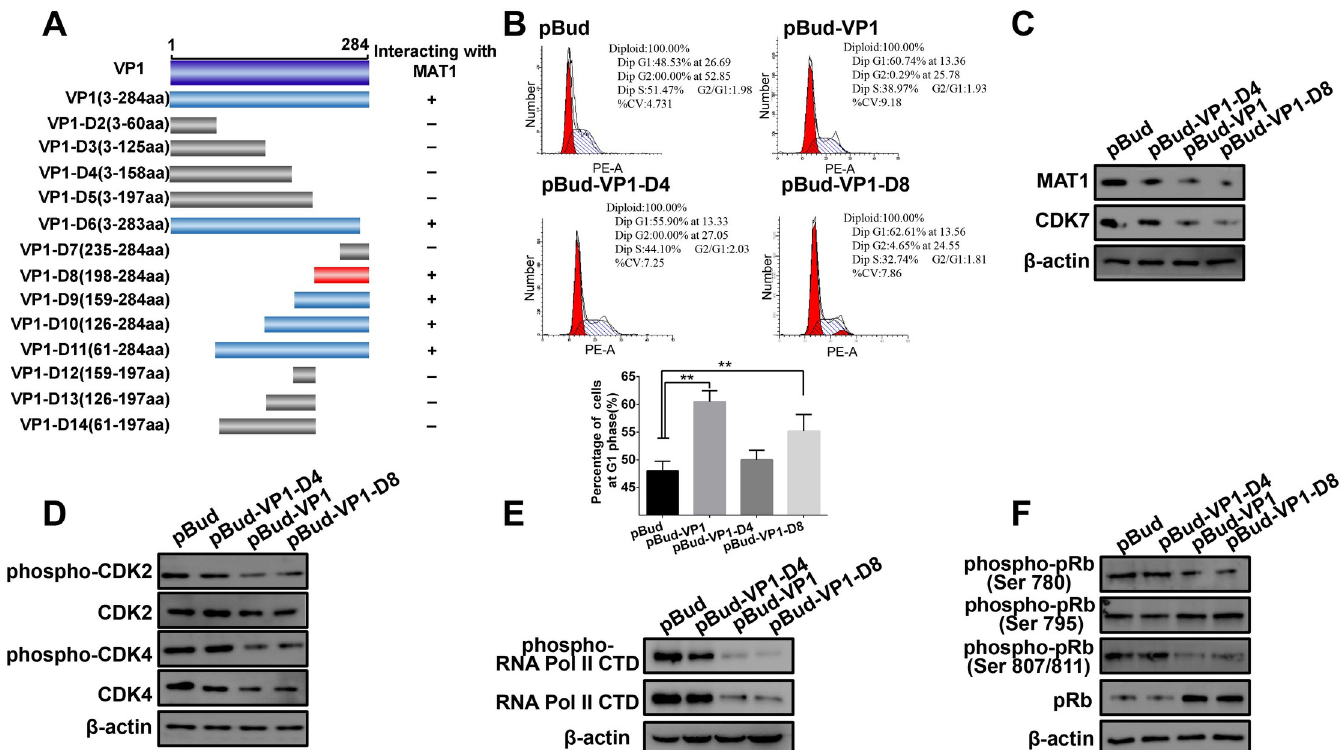
Fig 7. Mapping the minimum domain of VP1 interaction with MAT1. (A) Construction of a series of VP1 truncation/deletion mutants. The dark blue box is the full- length sequence encoded by VP1, the gray boxes are the VP1 deletion mutants that cannot interact with MAT1, the light blue boxes are the VP1 mutants that were detected to interact with MAT1, the D8 (red box) was the minimum domain of VP1 for the interaction (768–859 aa) in the VP1 C-terminus. (B) The interaction between VP1-D8 and MAT1 arrested cell cycle at the G1/S phase. pBud, pBud-VP1, pBud-VP1-D4 and pBud-VP1-D8 transfected cells for 48 h, and the cells were harvested and analyzed by flow cytometry. (C) VP1-D8 transfection down-regulated the expression of MAT1. Immunoblot analysis of the abundance of MAT1 in pBud, VP1, VP1-D4 and VP1-D8 transfected cells. Original blots are shown in S28 Fig for statistical analysis. (D) VP1-D8 transfection down-regulated the phosphorylation of CDK2 and CDK4. Western blot analysis of the accumulation of phosphorylated/nonphosphorylated CDK2 and CDK4 in different groups. Original blots are shown in S29 Fig for statistical analysis. (E) The accumulation of Pol II CTD, phospho-RNA Pol II CTD and β -actin were analyzed by Western blot. Original blots are shown in S30 Fig for statistical analysis. (F) Western blotting analysis of the expression of phosphorylated/nonphosphorylated pRb with specific antibodies. Original blots are shown in S31 Fig for statistical analysis. Values are shown as the mean ± SEM of three independent experiments. ( � P < 0.05, �� P < 0.01).